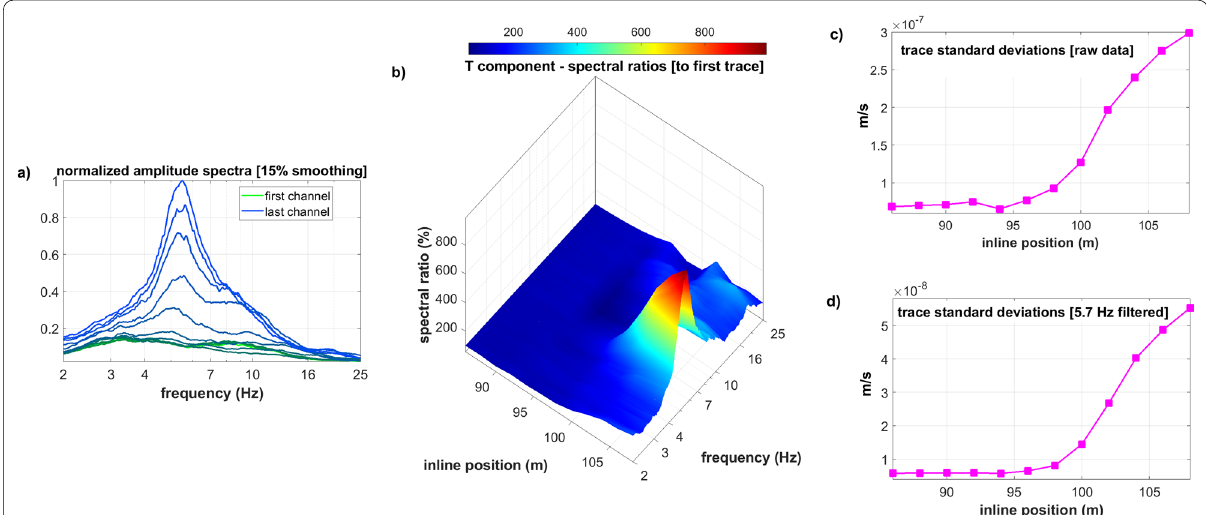
Fig. 21 Close up of the T-component passive data in the transition zone, where the stiff sandy sediments of the residual dune give way to softer sediments (inline positions 86–108 m in Fig. 20c): a normalized amplitude spectra (15% spectral smoothing); b spectral ratios with respect to the first channel; c standard deviations of the original (unfiltered) traces; d standard deviations of the traces filtered with a 5.7 Hz Gaussian filter. See text for